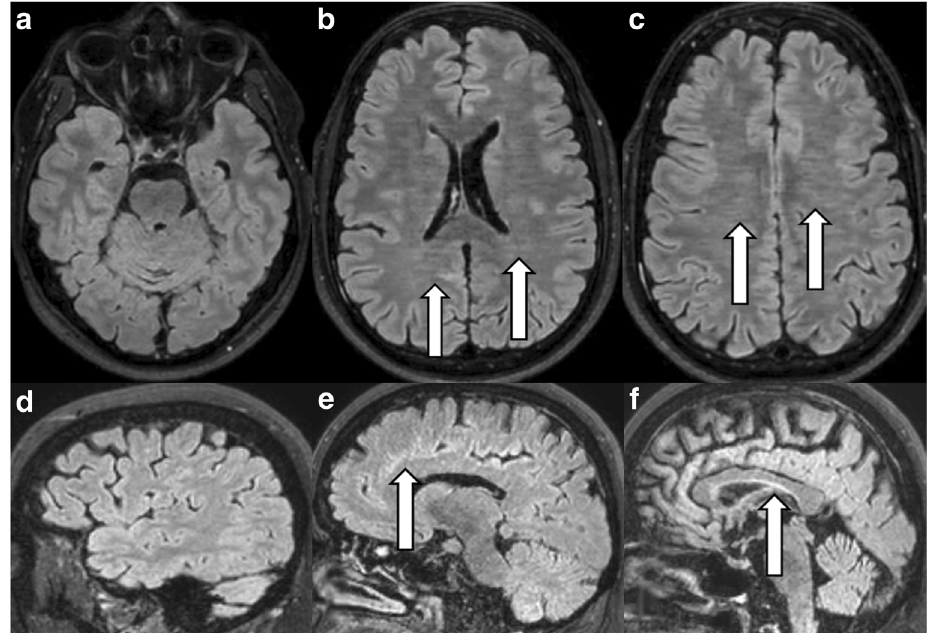
Fig. 4 The streaky-linear artefact type B. Streaky-linear artefacts type B ( white arrows ) are horizontally oriented lines only in the centre of the transverse reconstructed image on 3D FLAIR ( b , c ) that are not visible or less visible along the image periphery ( d ) or infratentorially ( a ). There are faintly oblique lines on sagittal source images ( e , f